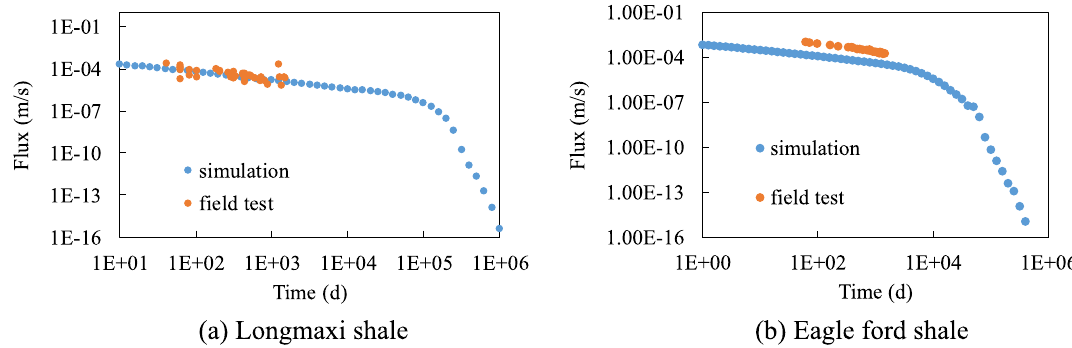
Figure 7. Comparison between simulation results and field test data (Longmaxi shale and Eagle ford